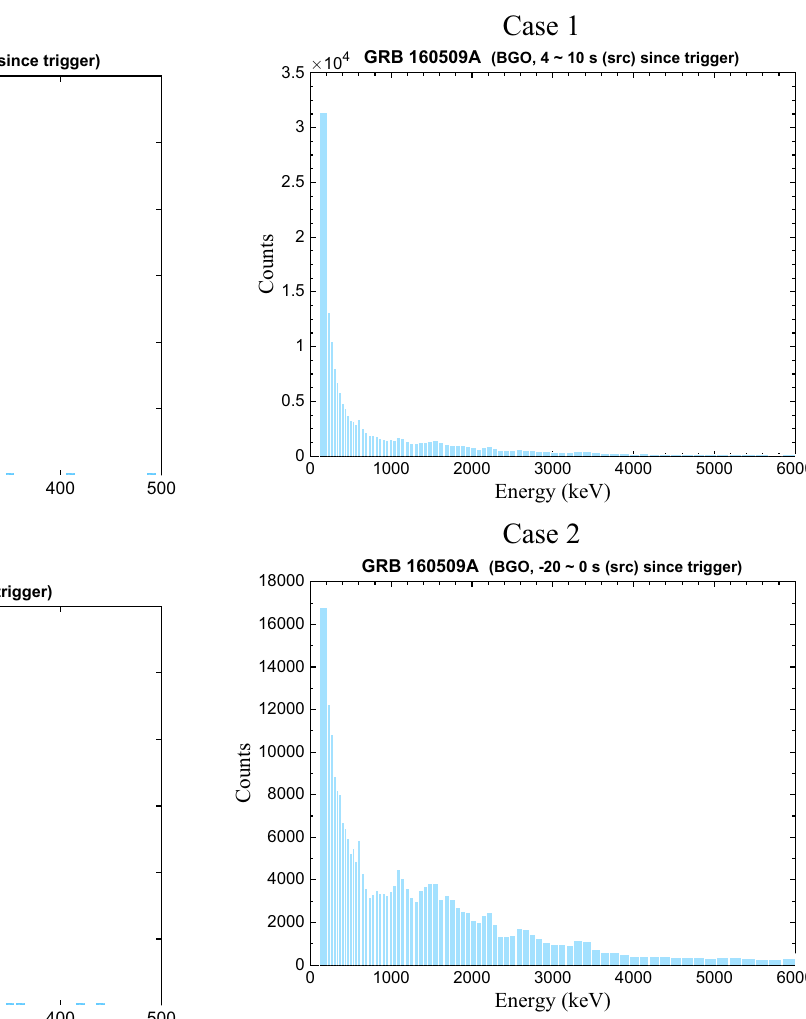
Fig. 16 The energy distribution histograms for GRB 160509A from BGOdata.Theupperoneusesthephotonswithin4–15s(with t obs /( 1 + z ) ) since trigger. The lower one uses the photons within − 20 to 0 s (with t obs /( 1 + z ) ) since trigger. The y -axis refers to the counts of certain rectangle. The bounds of the rectangles are chosen according to the energy channels of the